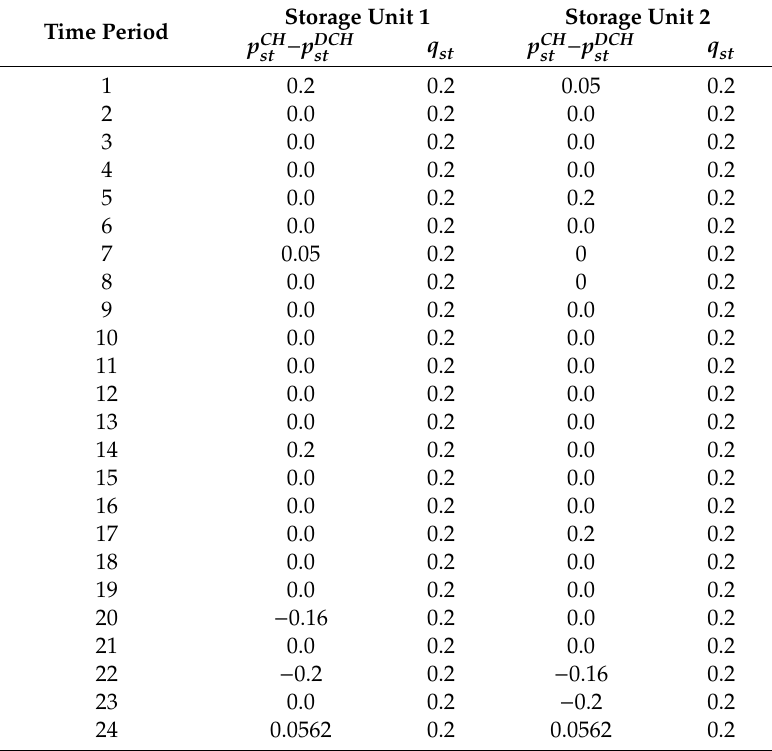
Figure 3. Results obtained from the proposed methodology disregarding ( a ) and considering ( b ) Equations (11)–(15) for the first scenario. Table 2. Results obtained from the second module for the first